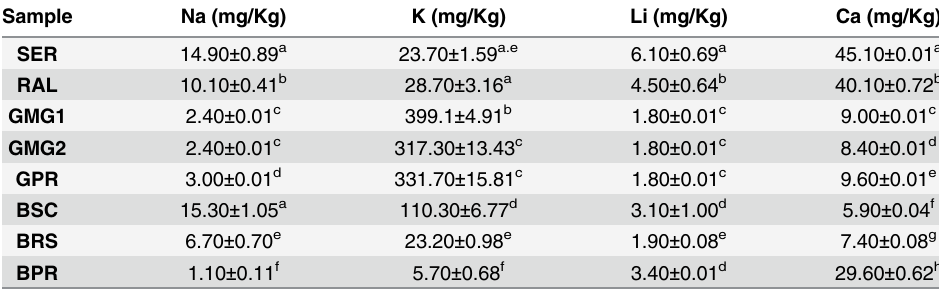
Values showing the same letter on the same column do not show signi fi cant difference (p > 0.05) through the Tukey test at 95% con fi dence